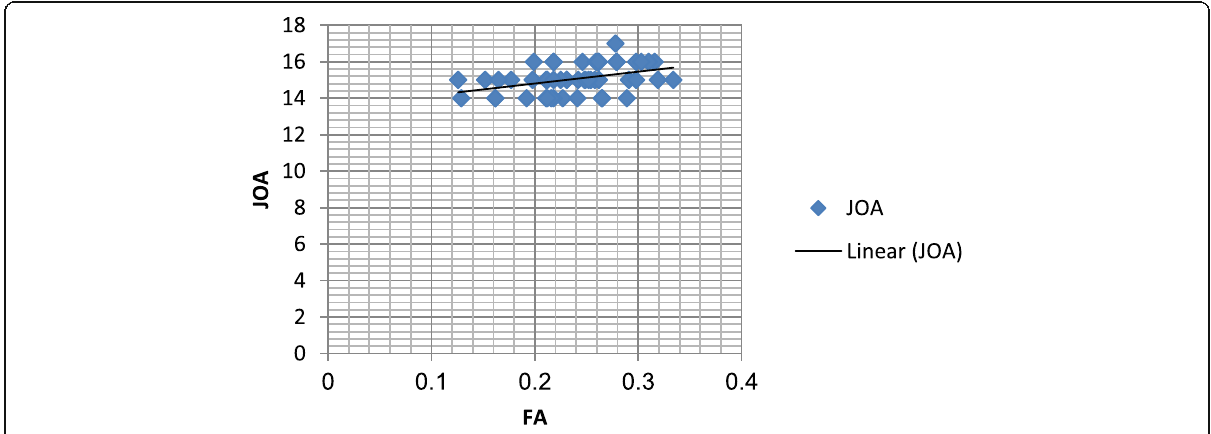
Fig. 2 Correlation between FA values and JOA scores for compressed